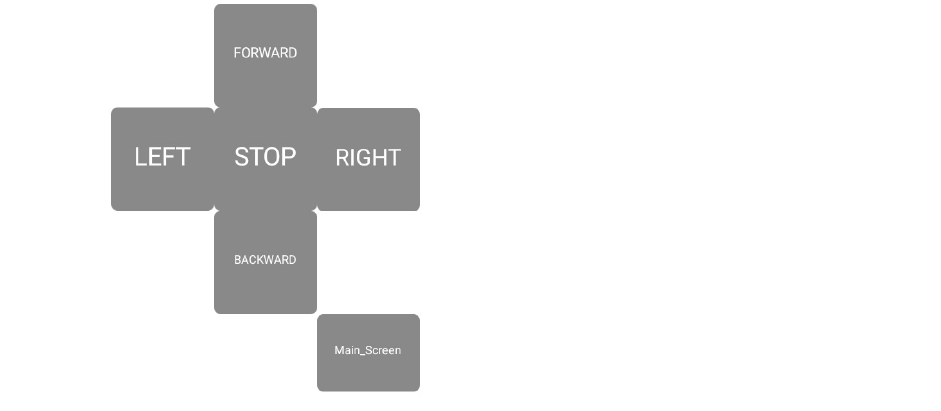
Figure 2. App control interface for controlling wheelchair on android app. The button shows forward, backward, left, right, and stop commands.